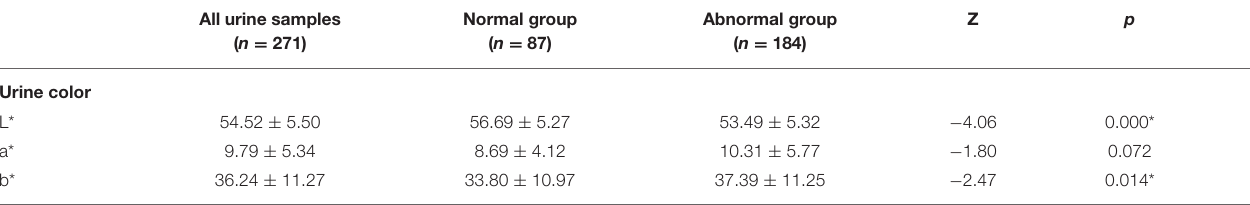
TABLE 2 | Comparison of urine samples with normal and abnormal urine dry chemical parameters in CIE L*a*b*. All urine samples ( n =